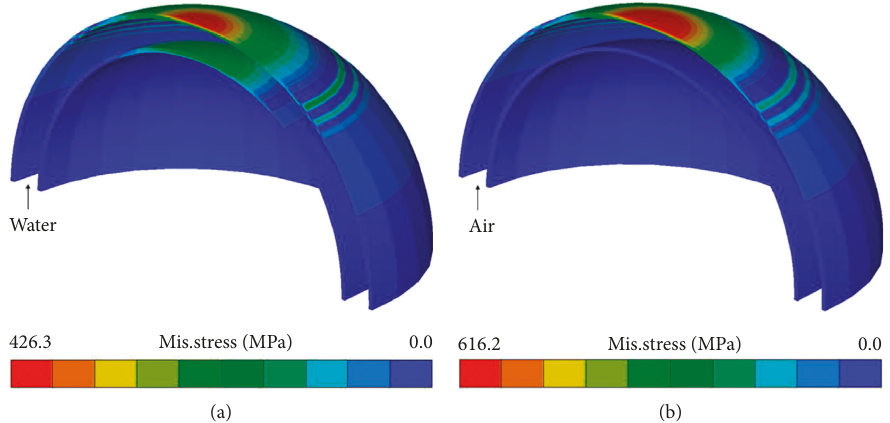
Figure 22: The Mises stress distribution of the double-layer shell structure. (a) Water filled between the two shells. (b) Air filled between the two shells.